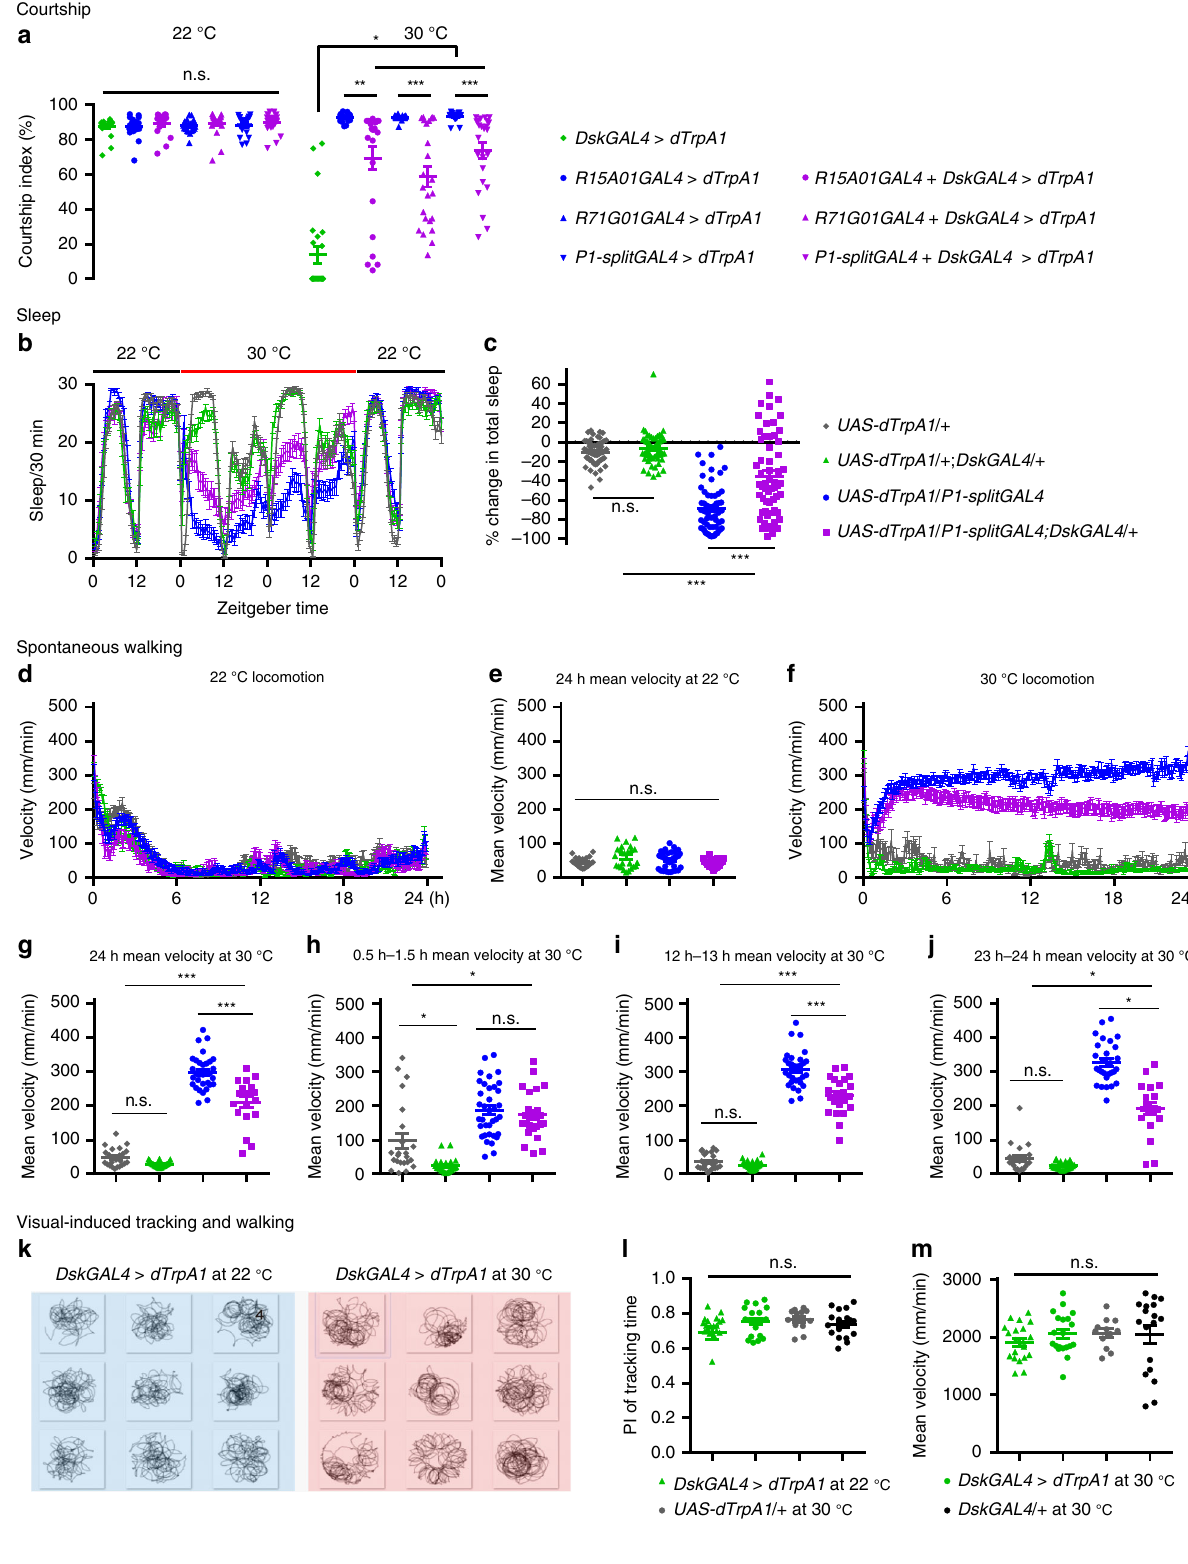
positive control to validate this technique, we observed substantial syb::spGFP1 – 10 in DskGAL4 neurons and expression of CD4:: GRASP signal using pan-neuronal driver R57C10LexA (Fig. 5f). spGFP11 in R15A01LexA labeled P1 neurons, and observed no These results indicate that there is no direct synaptic connection GFP signal (Fig. 5c, d). As dsx LexA labels much more neurons from Dsk neurons to P1 neurons, but do not exclude the possi- involved in male courtship including P1 neurons, we repeated bility that secreted DSK peptides might act on P1 neurons as long such activity-dependent GRASP experiment using DskGAL4 and as there are DSK receptors expressed there. In fact, P1 neurons do dsx LexA , and did not observe any signal either (Fig. 5e). As a NATURE COMMUNICATIONS| (2019) 10:4770